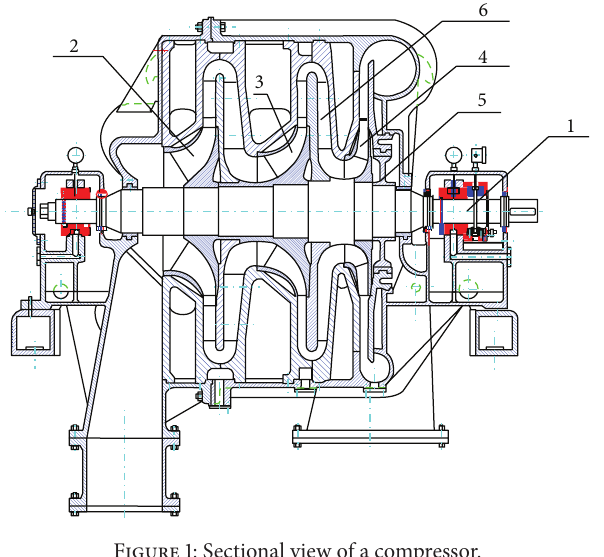
Figure 1: Sectional view of a compressor.